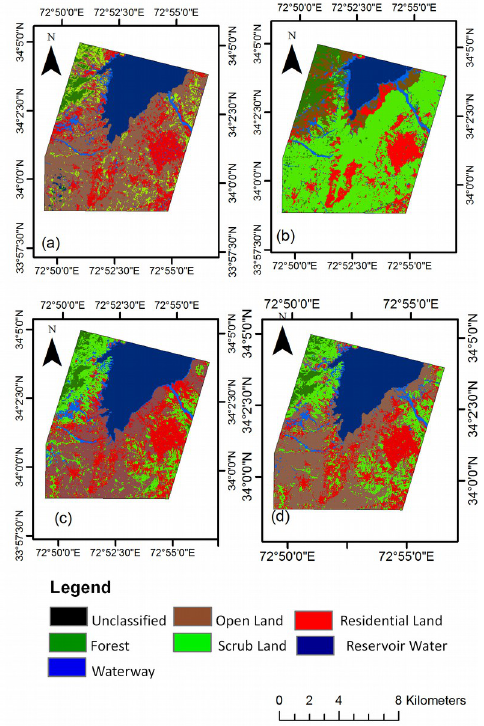
Figure 1. OLI data classified by SVM (a) winter (23